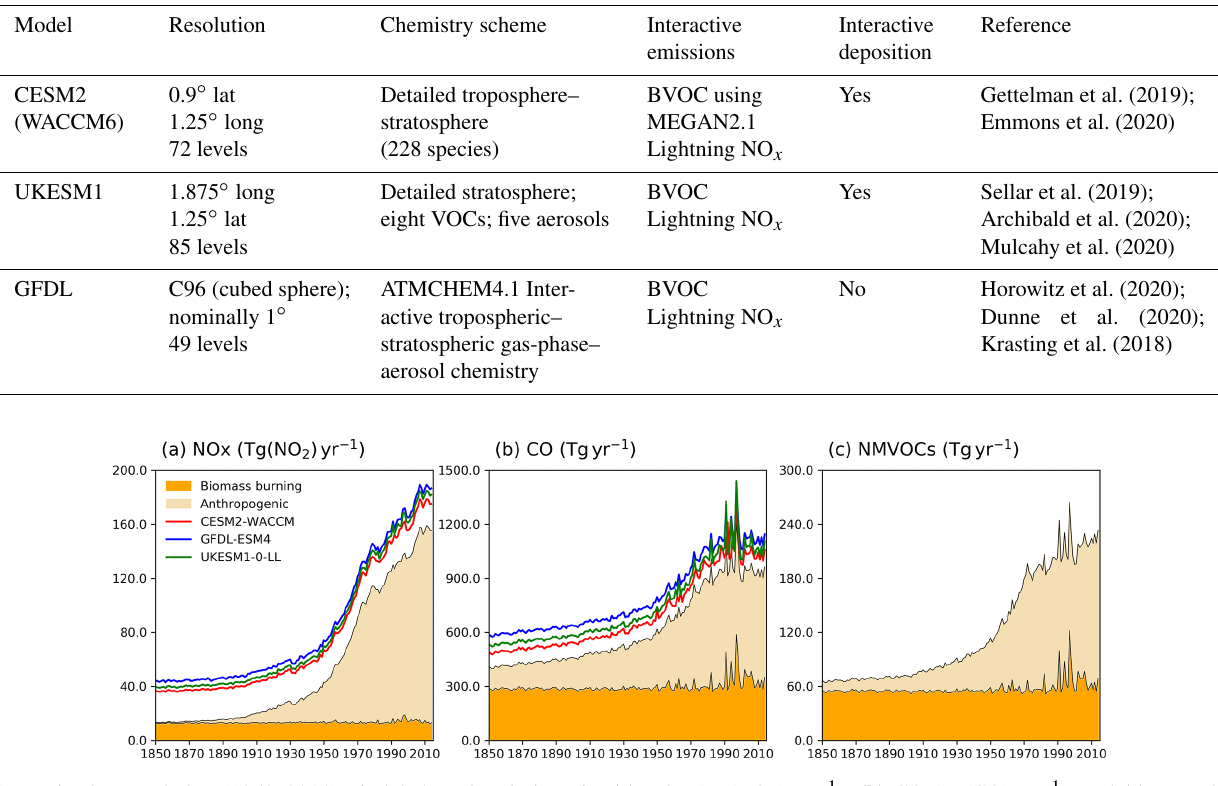
Figure 1. Time evolution (1850–2014) of global total emissions for (a) NO x (Tg(NO 2 ) yr − 1 ), (b) CO (Tg(CO) yr − 1 ), and (c) NMVOC (Tg(VOC) yr − 1 ). Orange is for biomass burning, and beige is for anthropogenic emissions (Hoesly et al., 2018). The coloured lines in the NO x and CO panels (red for CESM2-WACCM, blue for GFDL-ESM4, and green for UKESM1-0-LL) are the total emissions for each model, including natural sources. For historical biogenic VOC emissions, see Griffiths et al. (2020, Fig.